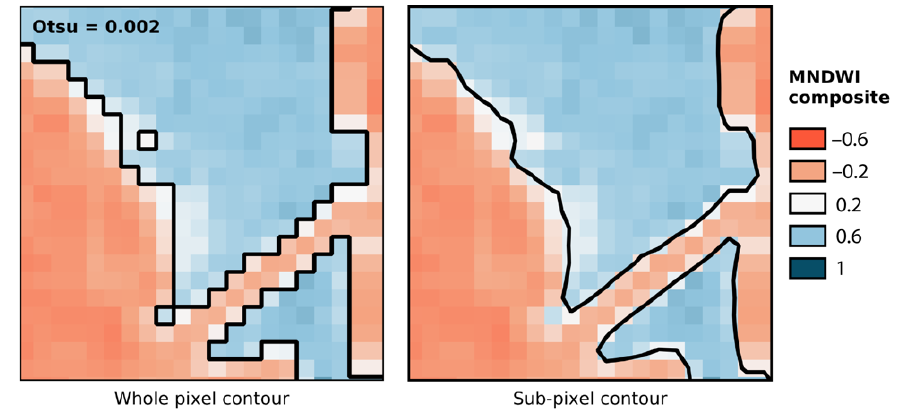
Figure 4. Sub-pixel contour compared to whole-pixel contour at Otsu